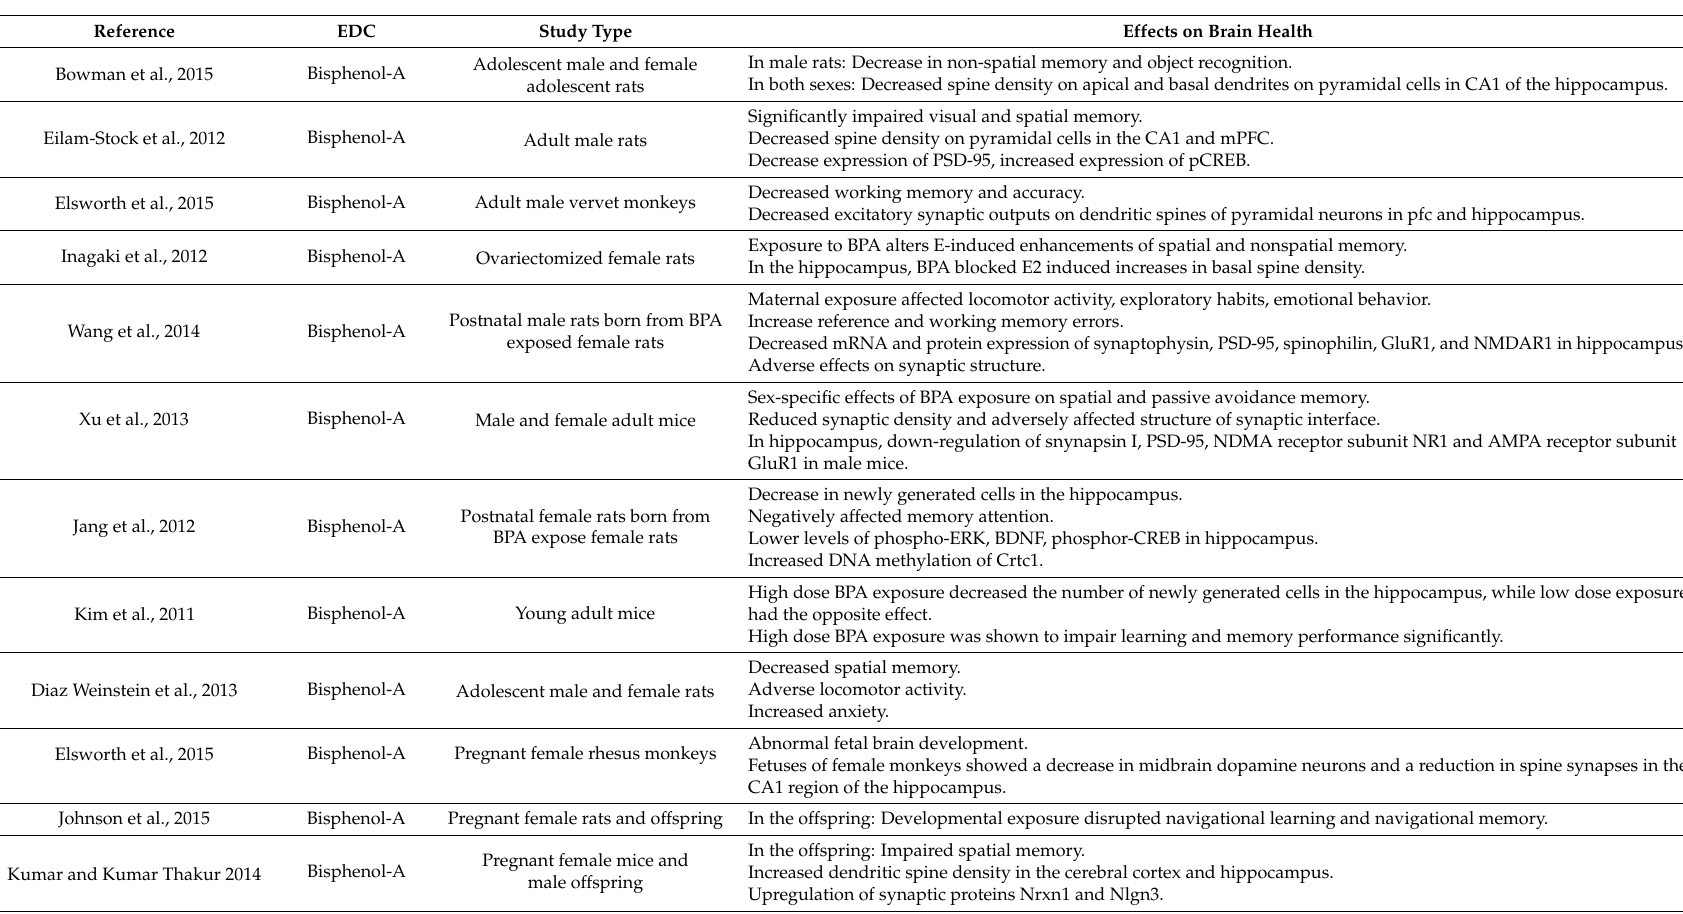
Table 3. Experimental animal studies showing association between Bisphenol-A, phthalates, polychlorinated biphenyls and